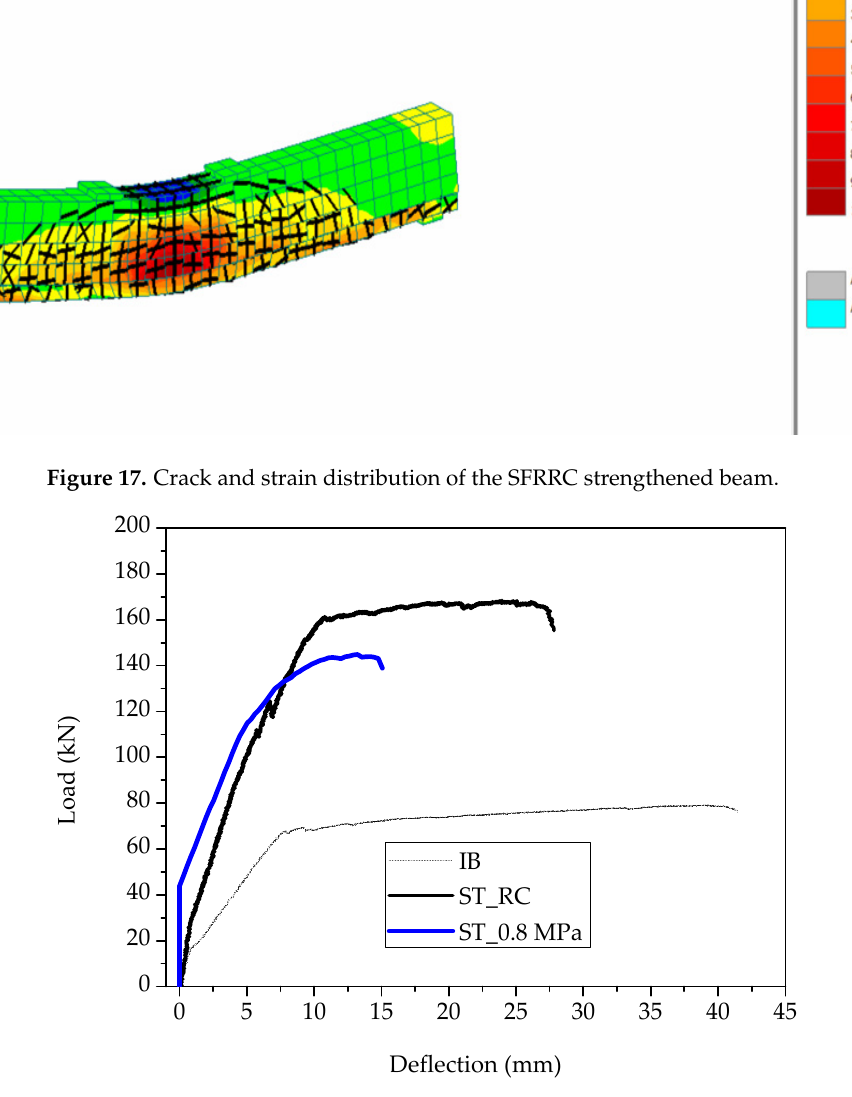
Figure 18. Load-mid span deflection results .